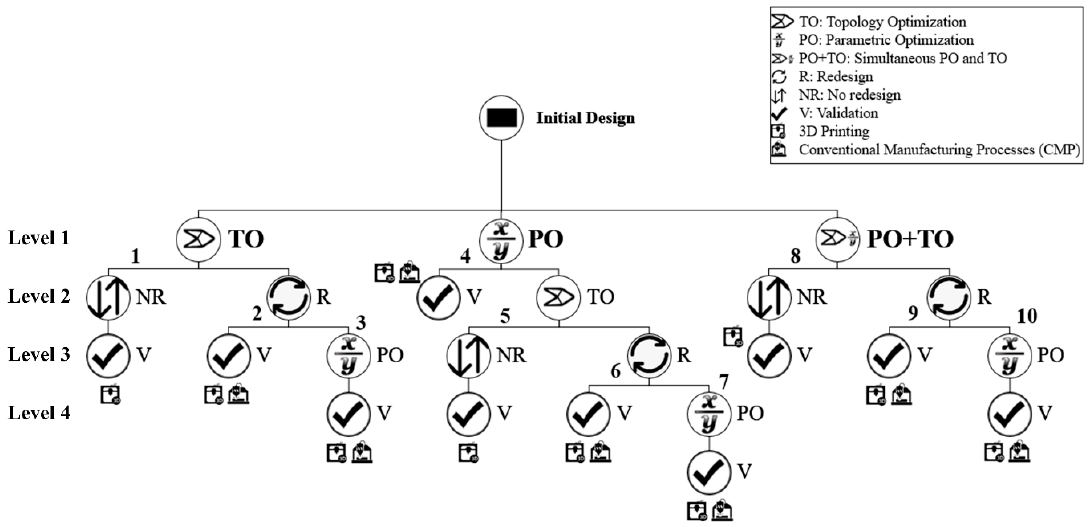
Figure 3. The ten design processes and their categorization based on the design workflow as well as the production method.